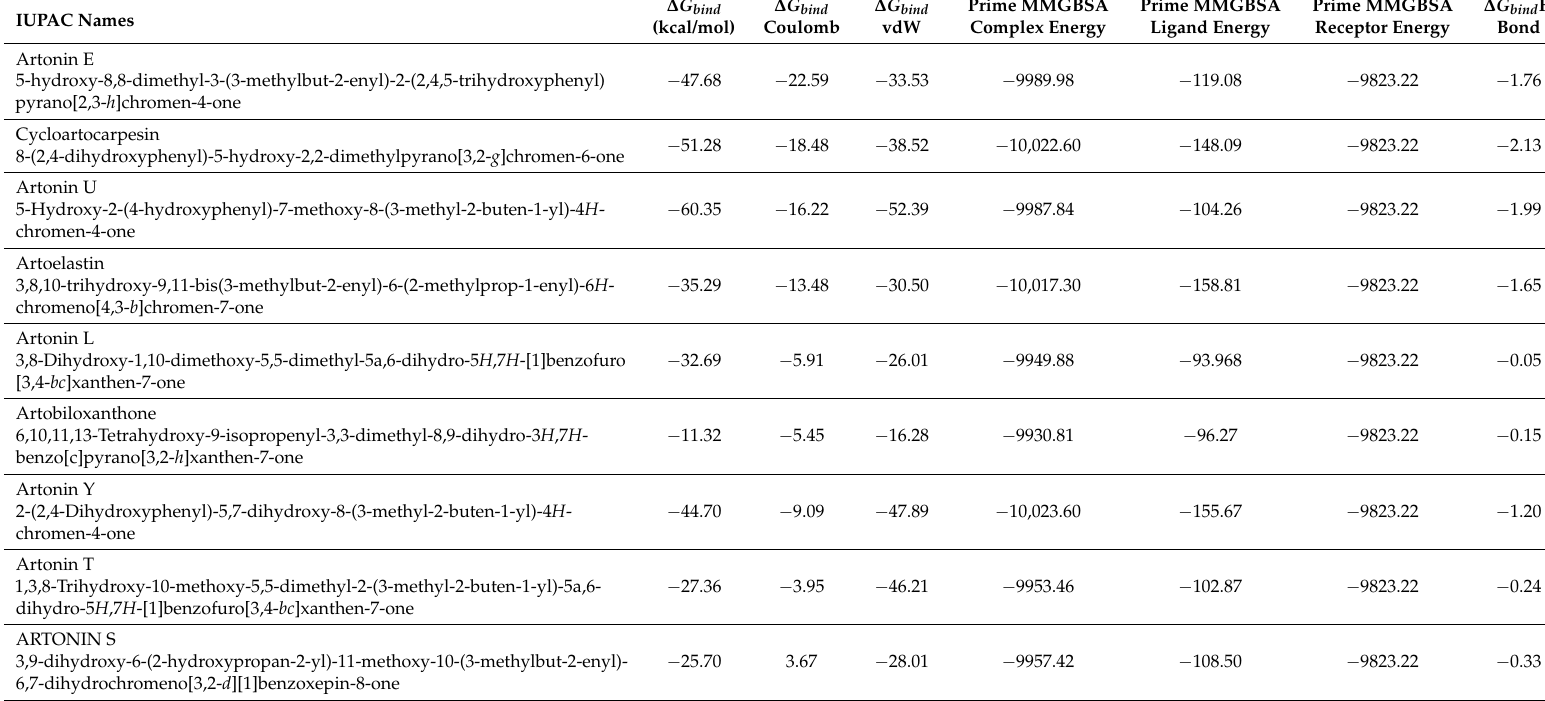
Table 3. Output properties from a Prime MM-GBSA